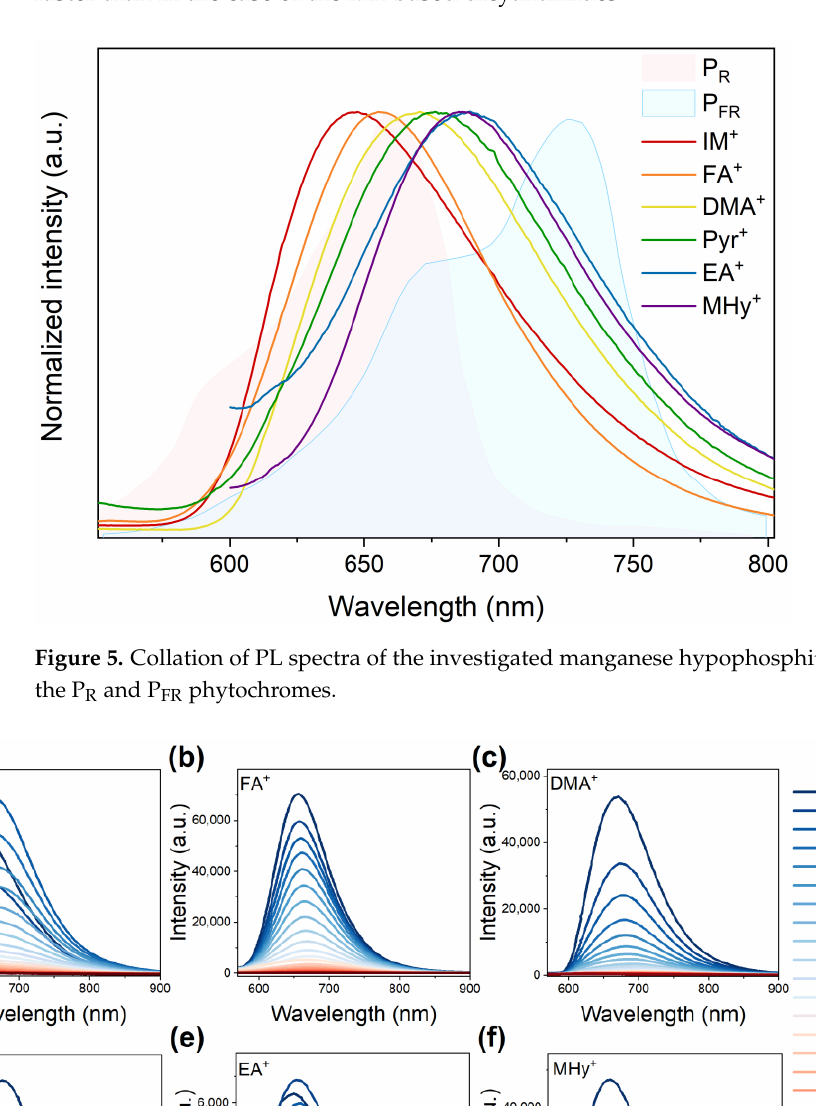
Figure 7. ( a ) Position of the PL band as a function of temperature up to 220 K; ( b ) integrated emission intensity of [A]Mn(H 2 POO) 3 as a function of temperature; and ( c ) energy-level diagram of Mn 2+ pre- senting the mechanism of PL quenching. The presented results explain the influence of some key structural factors on the op- tical properties of the family of Mn-based hybrid hypophosphites. Figure 8 summarizes the correlation between structural parameters, such as t F , octahedral deviation (δ), the number of Mn 2+ sites, and optical features. As can be seen, the compounds comprising linear cations should be analyzed separately from those with cyclic organic cations. Fur- thermore, there is no doubt that there is a correlation between the Goldschmidt tolerance factor and the energy band gap value. The higher the t F value, the lower the E g , so the optical band gap decreases for the samples with an almost ideal perovskite structure. For the IM and Pyr analogs, the t F and E g values are comparable; therefore, it is impossible to define any rules. Analysis of the results allowed for the correlation of the octahedral de- viation with the position of the PL band. The shift of the PL band is greater for manganese ions